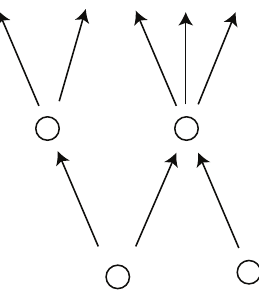
Figure 2 . A typical graph where there are side branches entering the tree from the starting point. The N in of the right node in the second layer should be 1 instead of 2, if we are interested in computing averages across the tree of nodes accessible from only the left starting